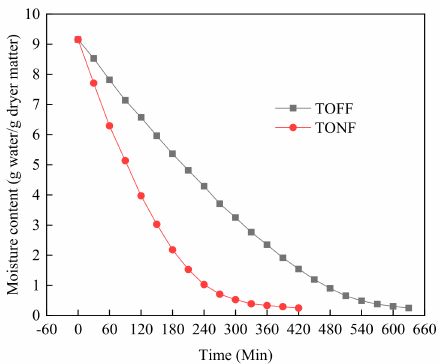
Figure 8. Changes of carrot moisture content with drying time.